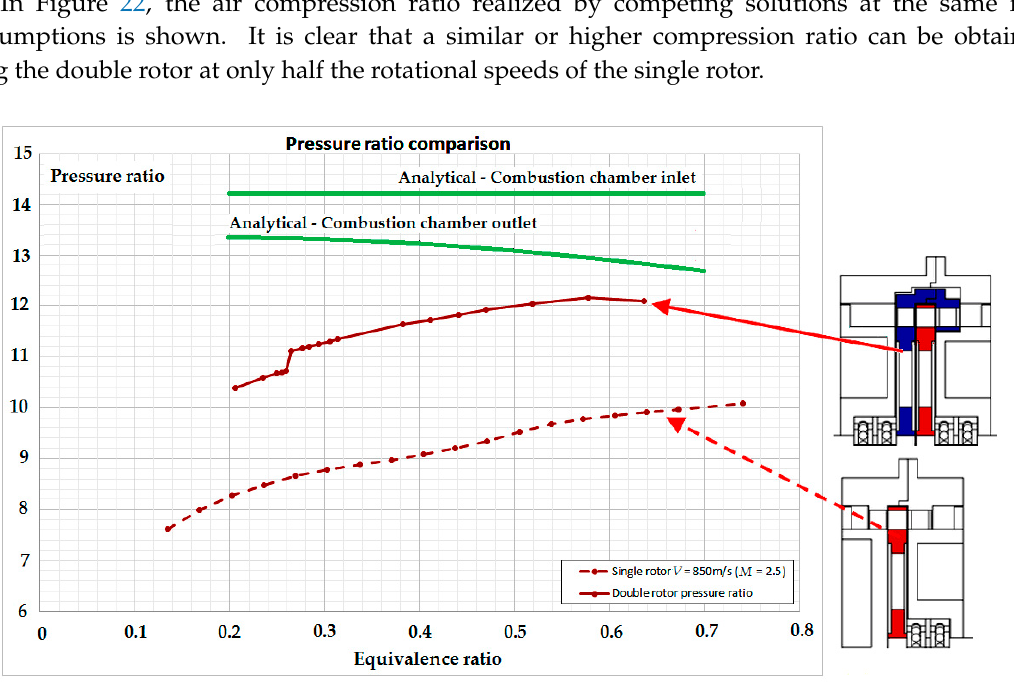
Figure 22. The air compression ratio in terms of the amount of fuel supplied in one- and two-shaft